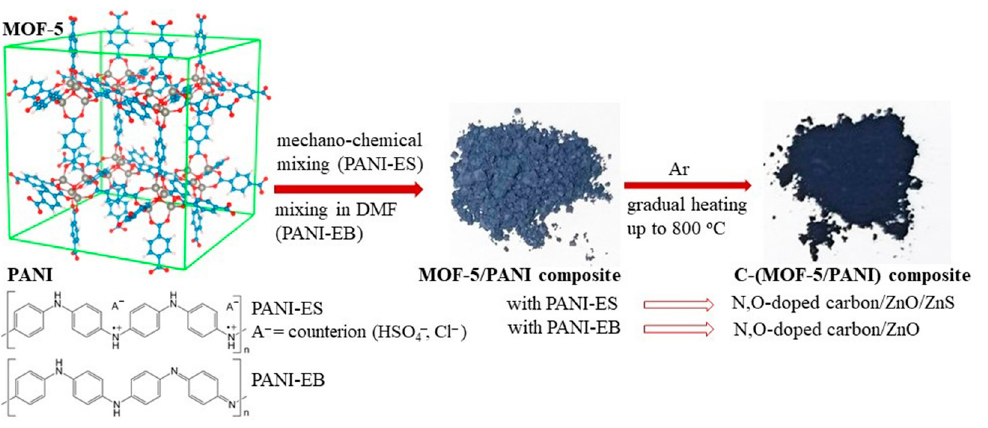
Figure 1. Schematic illustration of the preparation of C-(MOF-5/PANI) composites (photos refer to MOF/EB-2 precursor and C-MOF/EB-2 synthesized by its carbonization). The data on the yield of carbonization product, calculated as the mass of dry car- bonization product C-(MOF-5/PANI) per mass of dry MOF-5/PANI precursor × 100%, are presented in Table 1. For the C-MOF/ES series, the carbonization yield was in the range 40.2–48.6% and decreased with increasing the amount of MOF-5 in the precursor. A similar range of yield was obtained for the C-MOF/EB series, 43.2–48.2%, but the yield increased